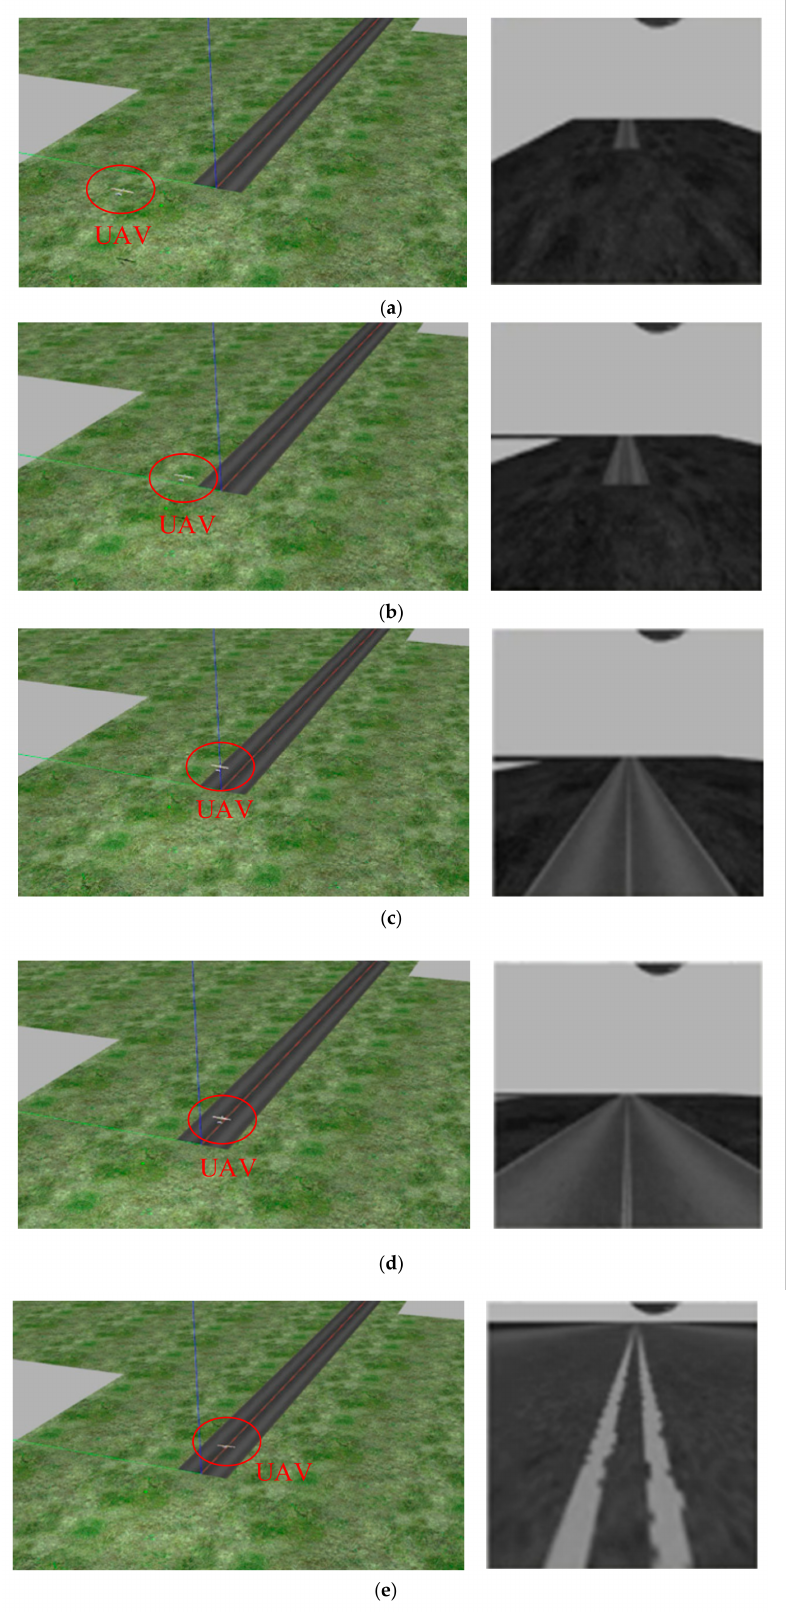
Figure 9. The landing process under case 1 ( a – e ). ( a ) t = 0.0 s; ( b ) t = 1.08 s; ( c ) t = 2.10 s; ( d ) t = 3.07 s; ( e ) t = 4.12